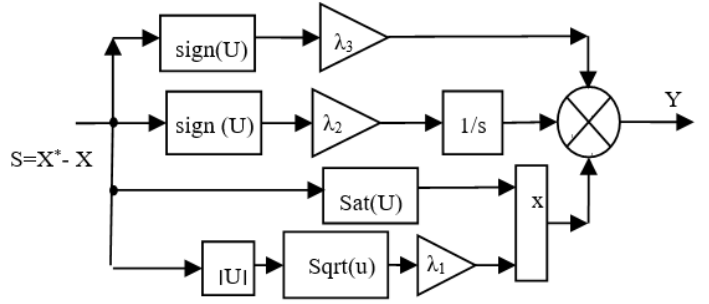
Figure 2. The command law structure of the proposed TOSM controller.